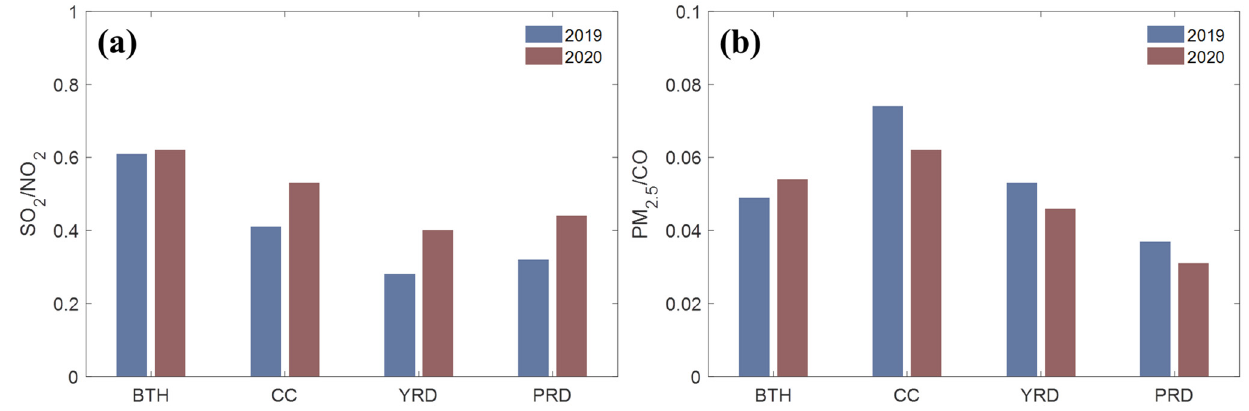
Figure 5. The values of SO 2 /NO 2 ( a ) and PM 2.5 /CO ( b ) in the BTH, the CC, the YRD, and the PRD. From the perspective of the contributions of all emissions changes to PM 2.5 , we cal- culate the PM 2.5 mass concentration under similar meteorological conditions (Table 4).